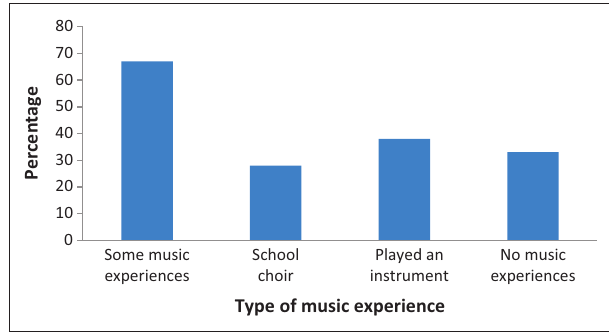
FIGURE 1: Students’ music experiences during school years.